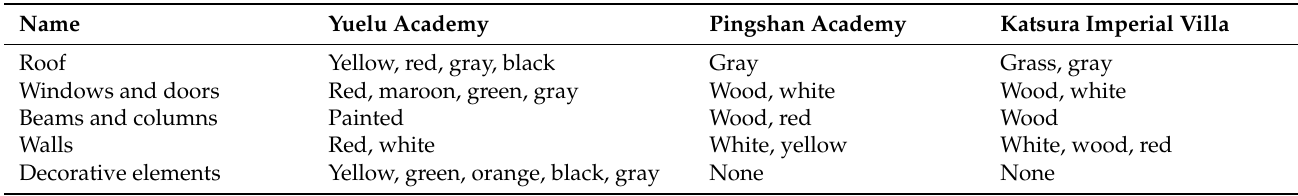
Table 2. Analysis of the use of color in the Academy gardens.